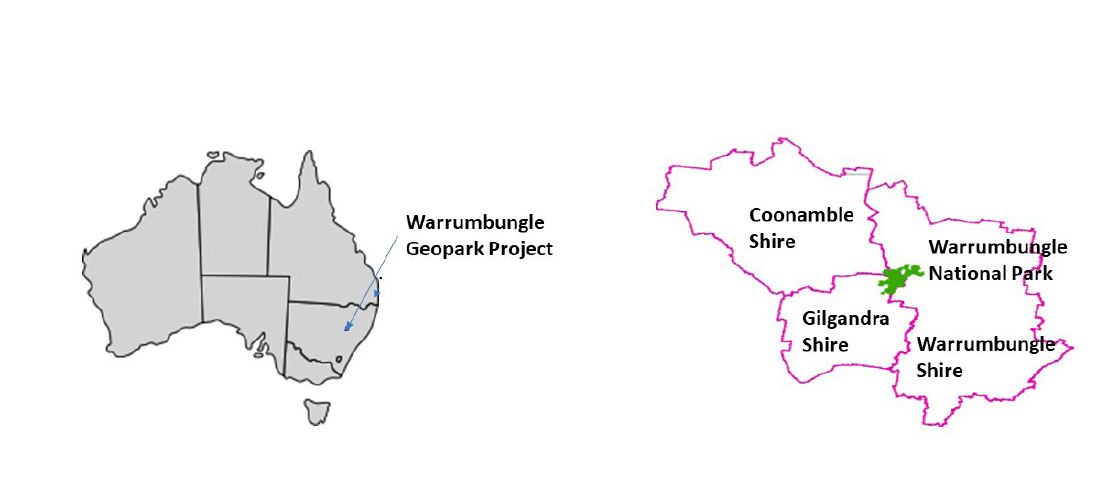
Figure 3. Warrumbungle Pre-Aspiring UNESCO Global Geopark area comprising the whole of Warrumbungle, Gilgandra, and Coonamble Shires, totaling some 27,000 square kilometers in area and inclusive of the Warrumbungle National Park, located adjacent to the township of Coonabarabran, North-West New South